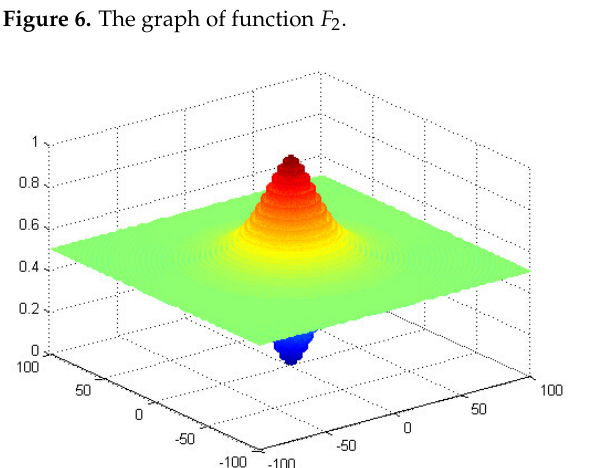
Figure 7. The graph of function F 3 . F 4 : Schaffer’s f 7 [39].